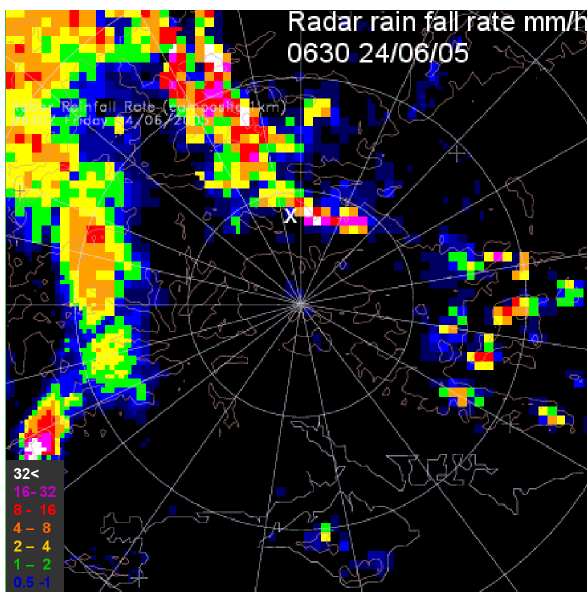
Fig. 3d. Composite weather radar rainfall for the 24 June 2005 at 07:15UTC. The white cross indicate Linkenholt site. The rain rate/h is indicated by the colour scale on the bottom left. The bulls- eye is centred at the Chilbolton radar with the first and second cir- cles of radius 25 and